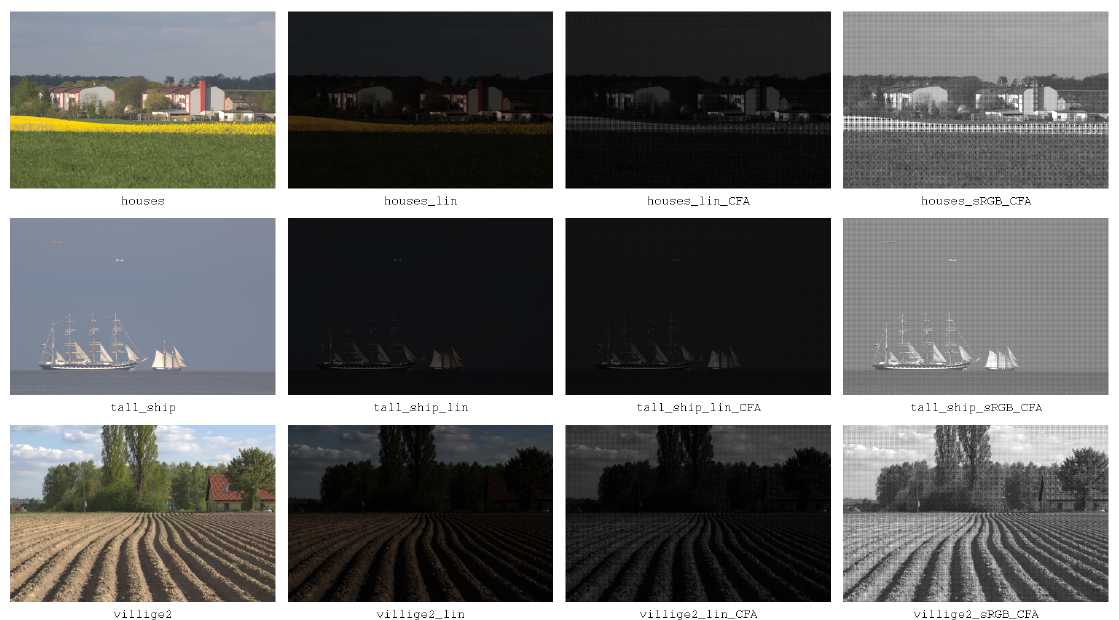
Figure 10. Test images for different stages of raw image processing